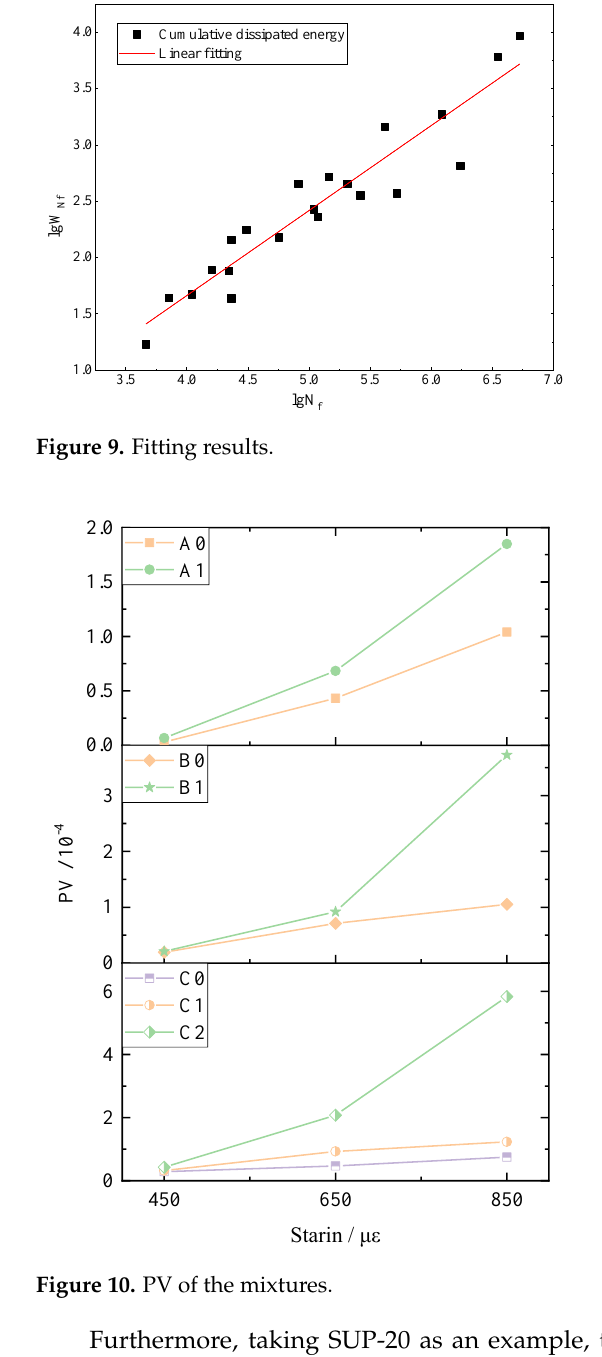
C2C1C0B1B0A1A0 ( c ) Figure 8. Cumulative dissipated energy: ( a ) 450 με , ( b ) 650 με and ( c ) 850 με .